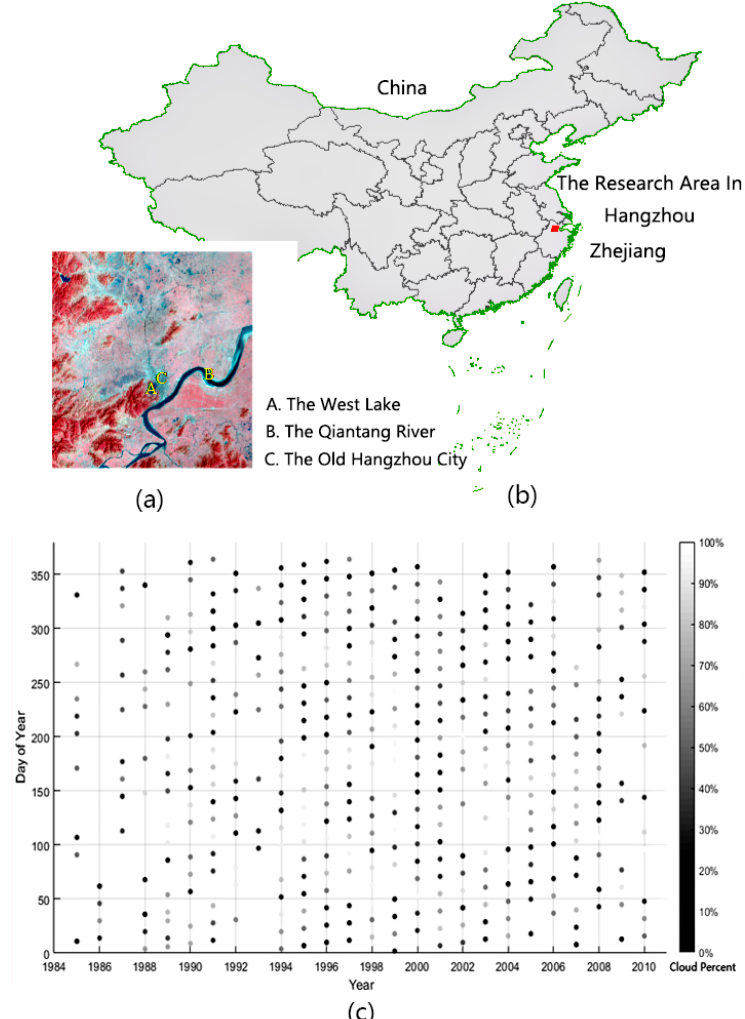
Figure 1. ( a ) Image acquired on March 3, 1986, of the research area, Hangzhou City. ( b ) Location of Hangzhou City (red square) in Zhejiang Province, China. The border of China is indicated with green polygons, and the boundaries of different provinces are indicated with gray polygons. ( c ) Image acquisition dates and proportions of noise caused by clouds and cloud shadows. All the images were taken by Landsat 5.